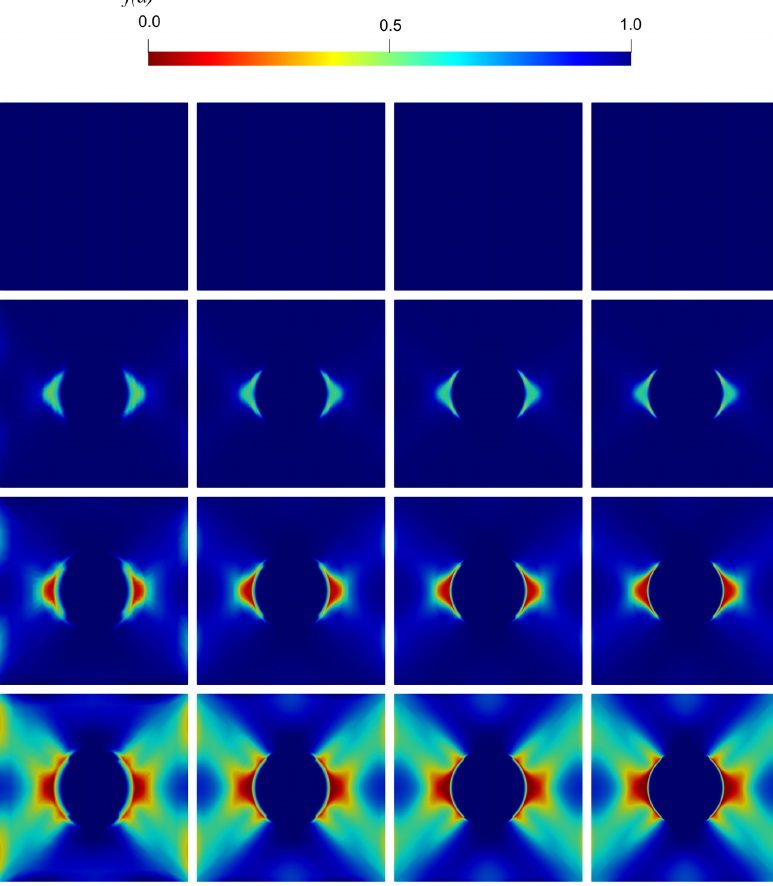
Figure 5: Tension: distribution of damage function 𝑓(𝑑) for 1024, 3136, 6400 and 10,816 elements (from left to right) for steps 200, 245, 255 and 270